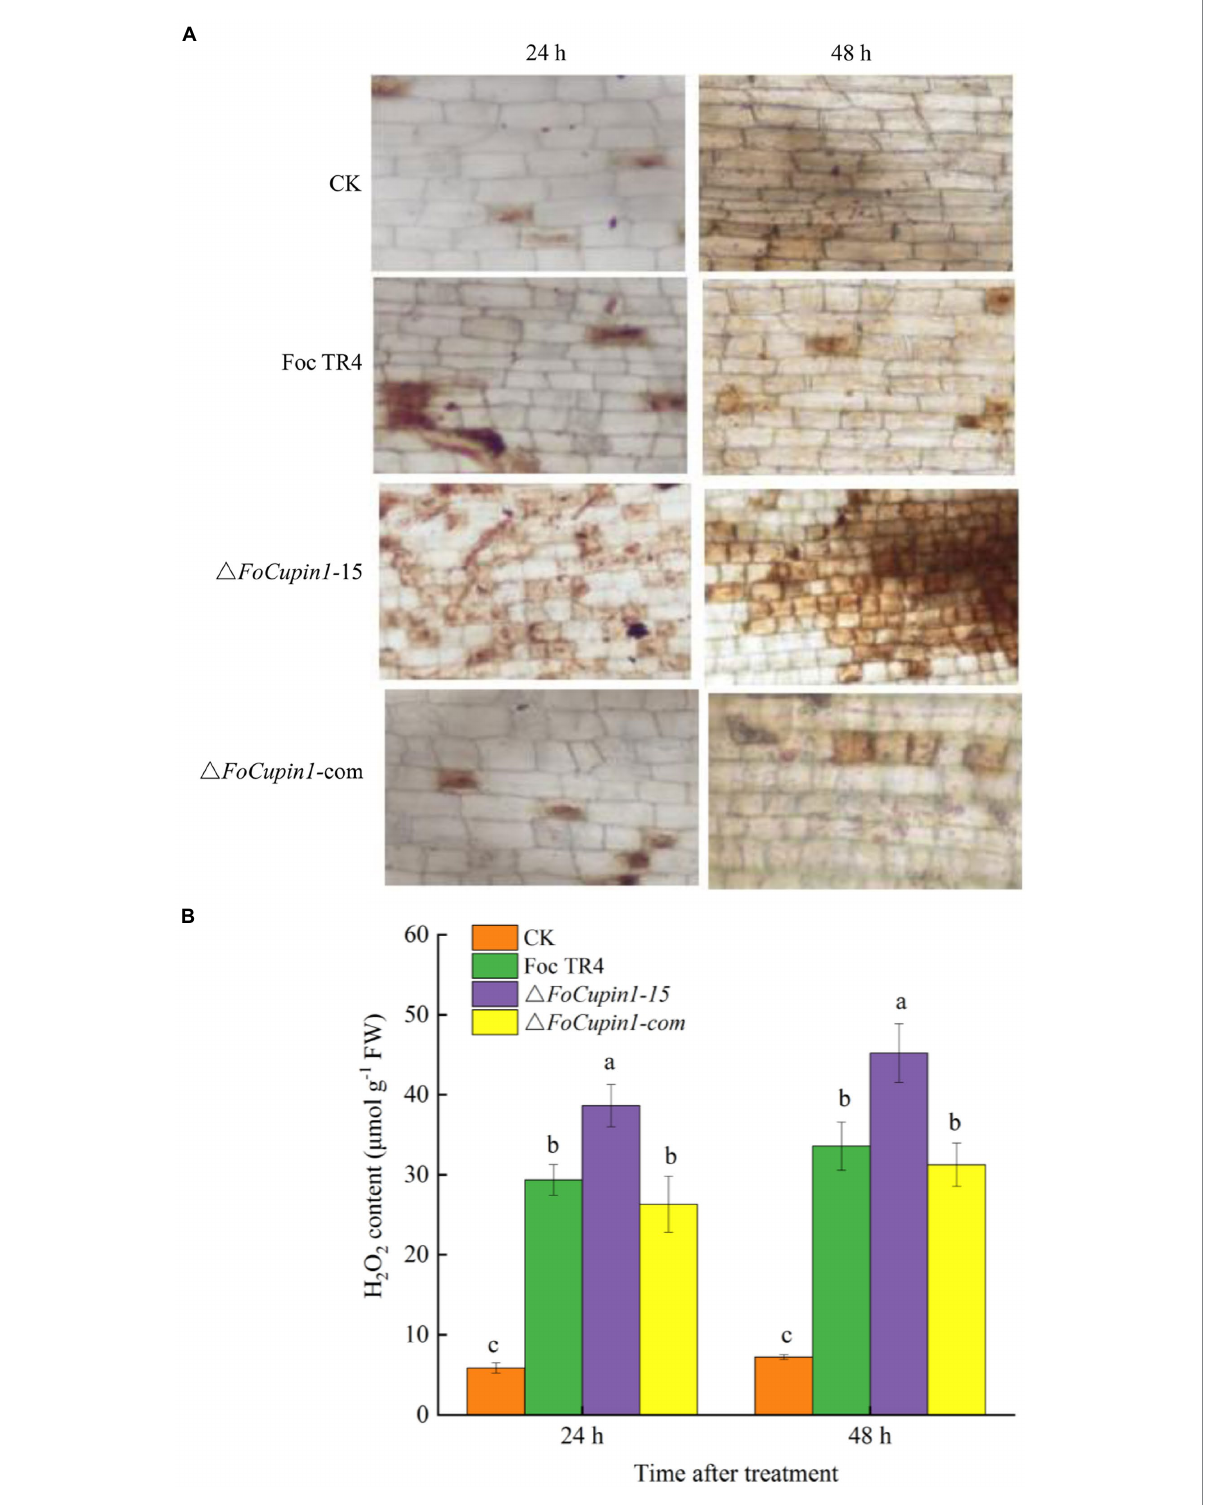
FIGURE 7 FoCupin1 induces ROS accumulation in banana roots. (A) H 2 O 2 production detected by DAB staining (magnification 100×). (B) Quantitative analysis of H 2 O 2 content in banana roots. Experiments were repeated at least three times. Values are the means (±SE) based on three independent experiments and bars indicate standard deviations. The letters above the bars are significantly different at 0.05